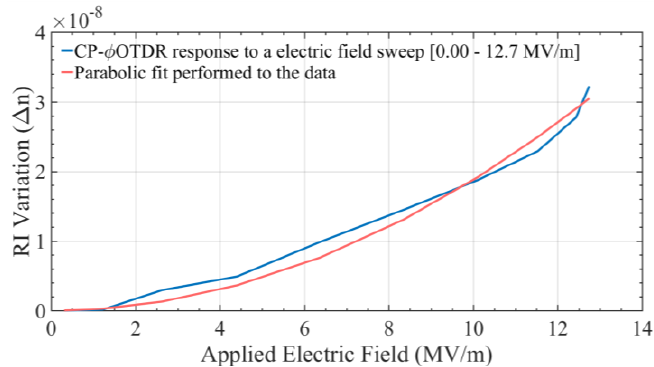
Figure 5. Blue line: RI variation measured by the EO sensor, averaged over ~1 s (60 voltage sweeps). Red line: parabolic fit performed to the data.